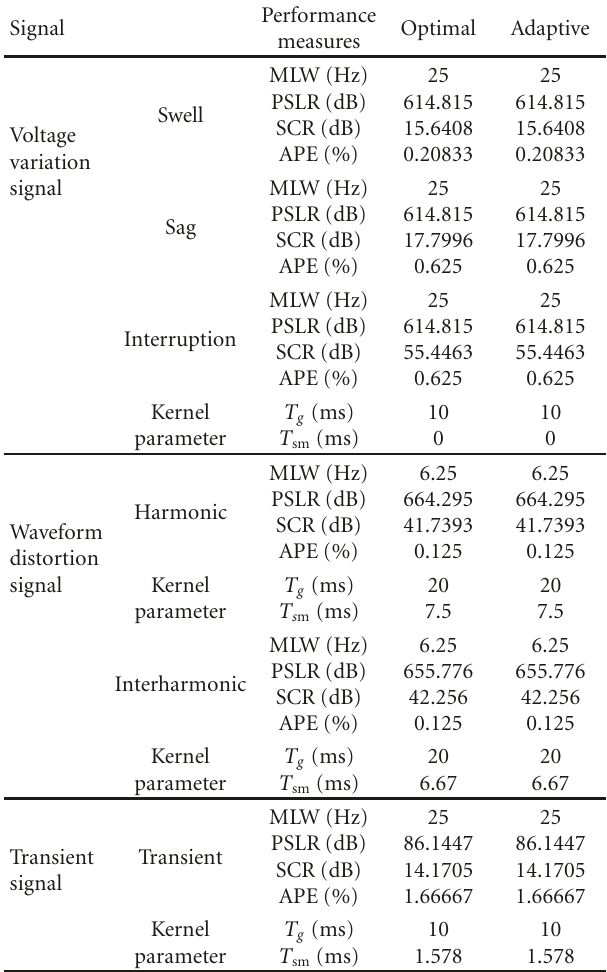
Table 8: Performance comparison between optimal and adaptive optimal kernel